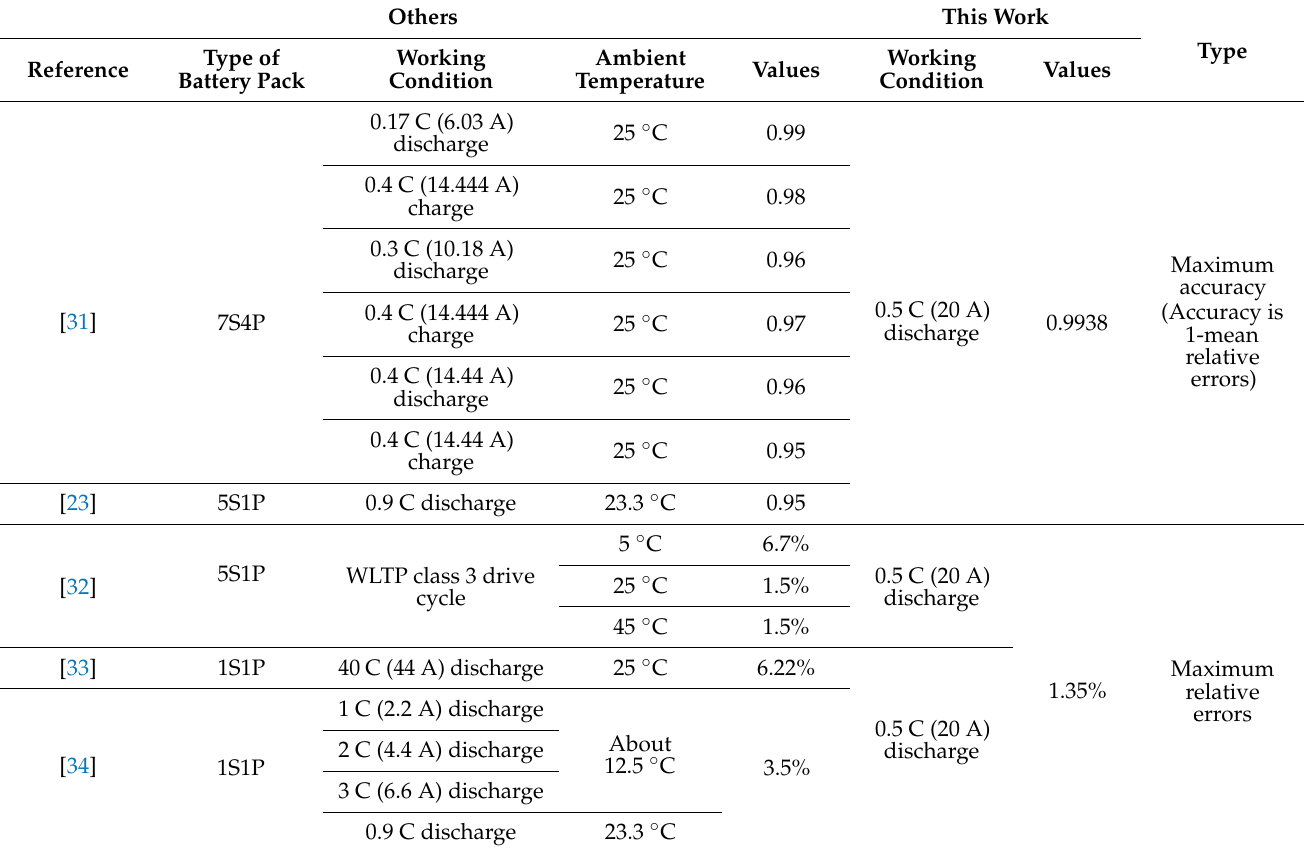
Table 6. Comparison results with other authors regarding temperature-simulation